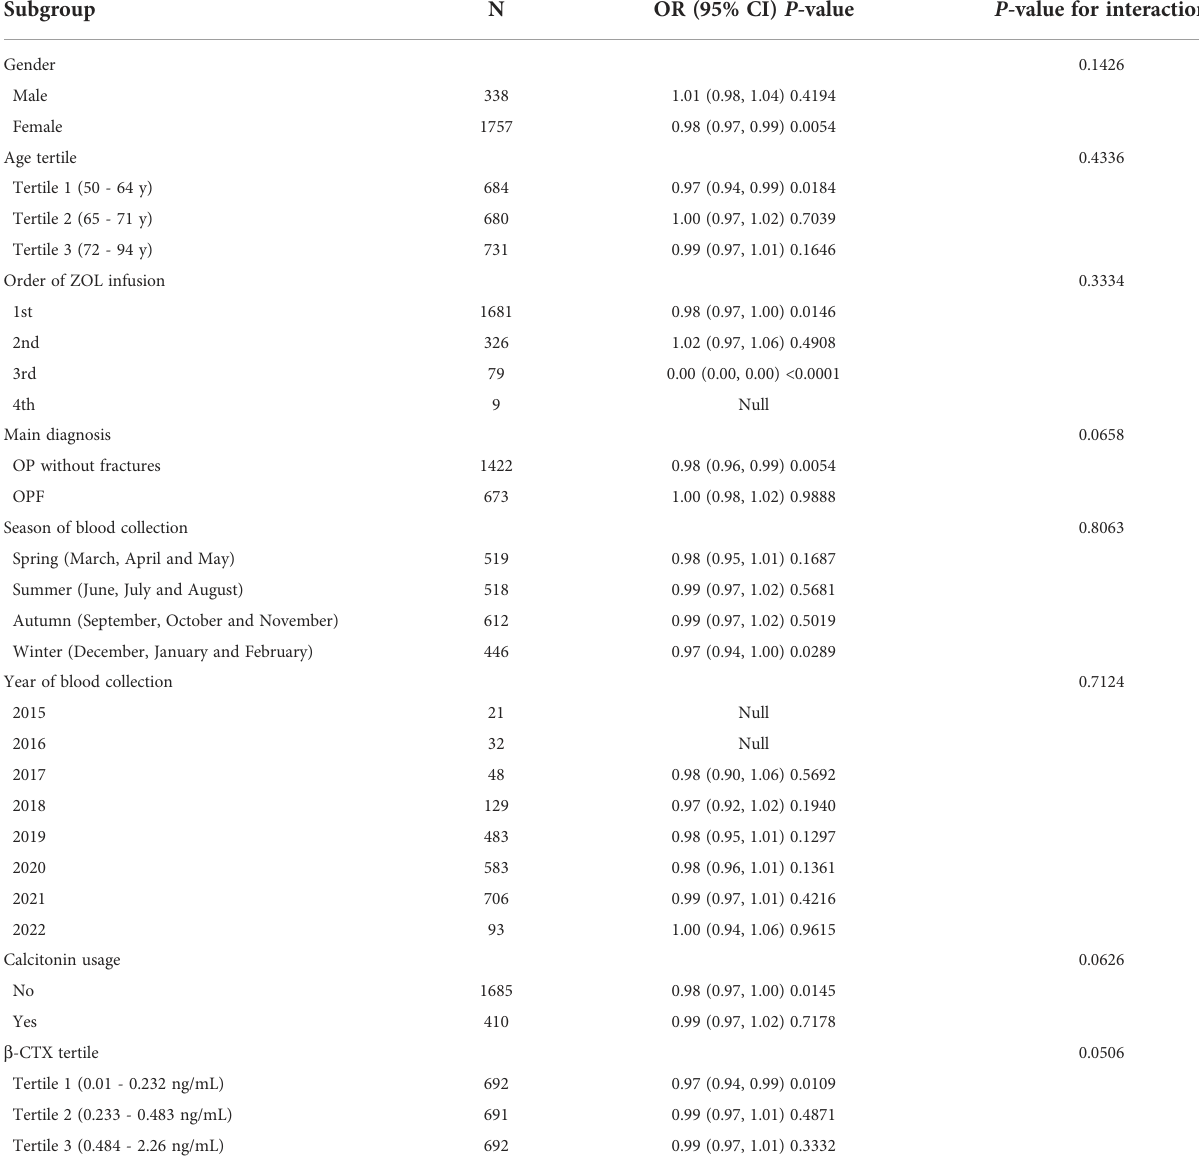
Adjusted for age; gender, order of ZOL infusion, main diagnosis, season of blood collection, year of blood collection, calcitonin usage and b -CTX except the subgroup variable. OR, odds ratio; CI, con fi dence interval; b -CTX, beta-C-terminal telopeptide of type I collagen; 25(OH)D, 25-hydroxy vitamin D; ZOL, zoledronate.